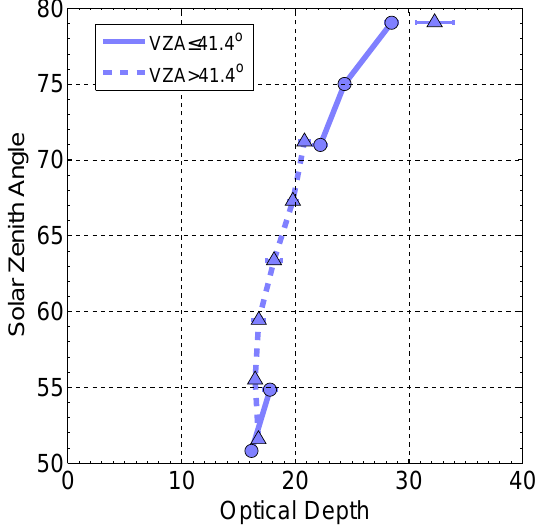
Figure 5. Mean optical depth vs. solar zenith angle for different ranges of viewing zenith angle (VZA, see legend). The errors are discussed in the text and are represented by horizontal error bars. In most cases they are too small to be visible.